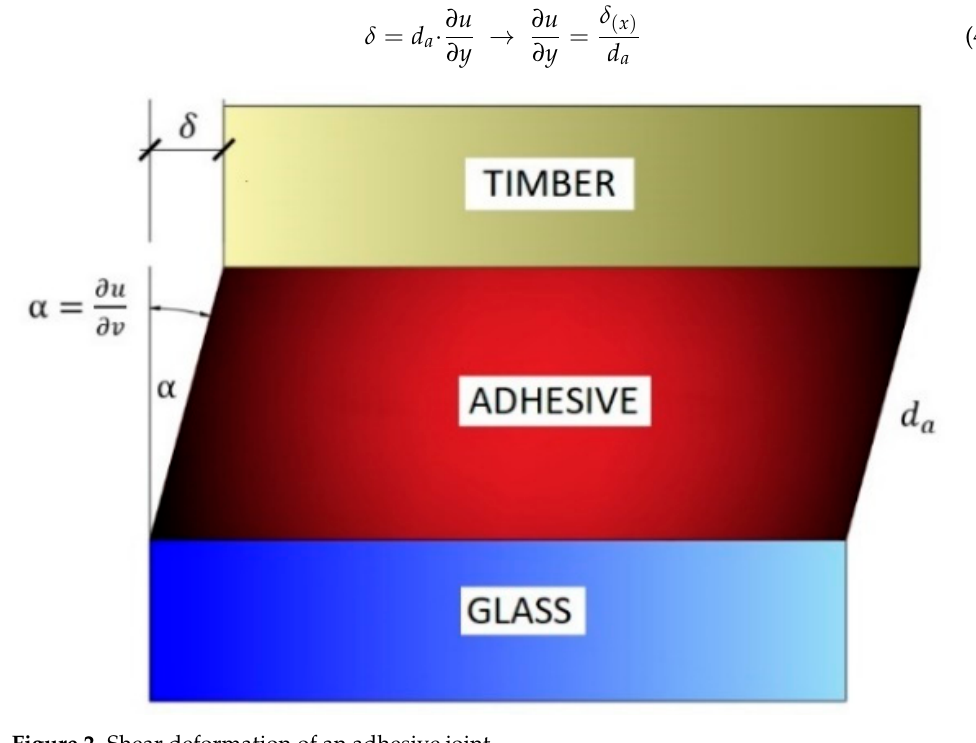
Figure 2. Shear deformation of an adhesive joint.